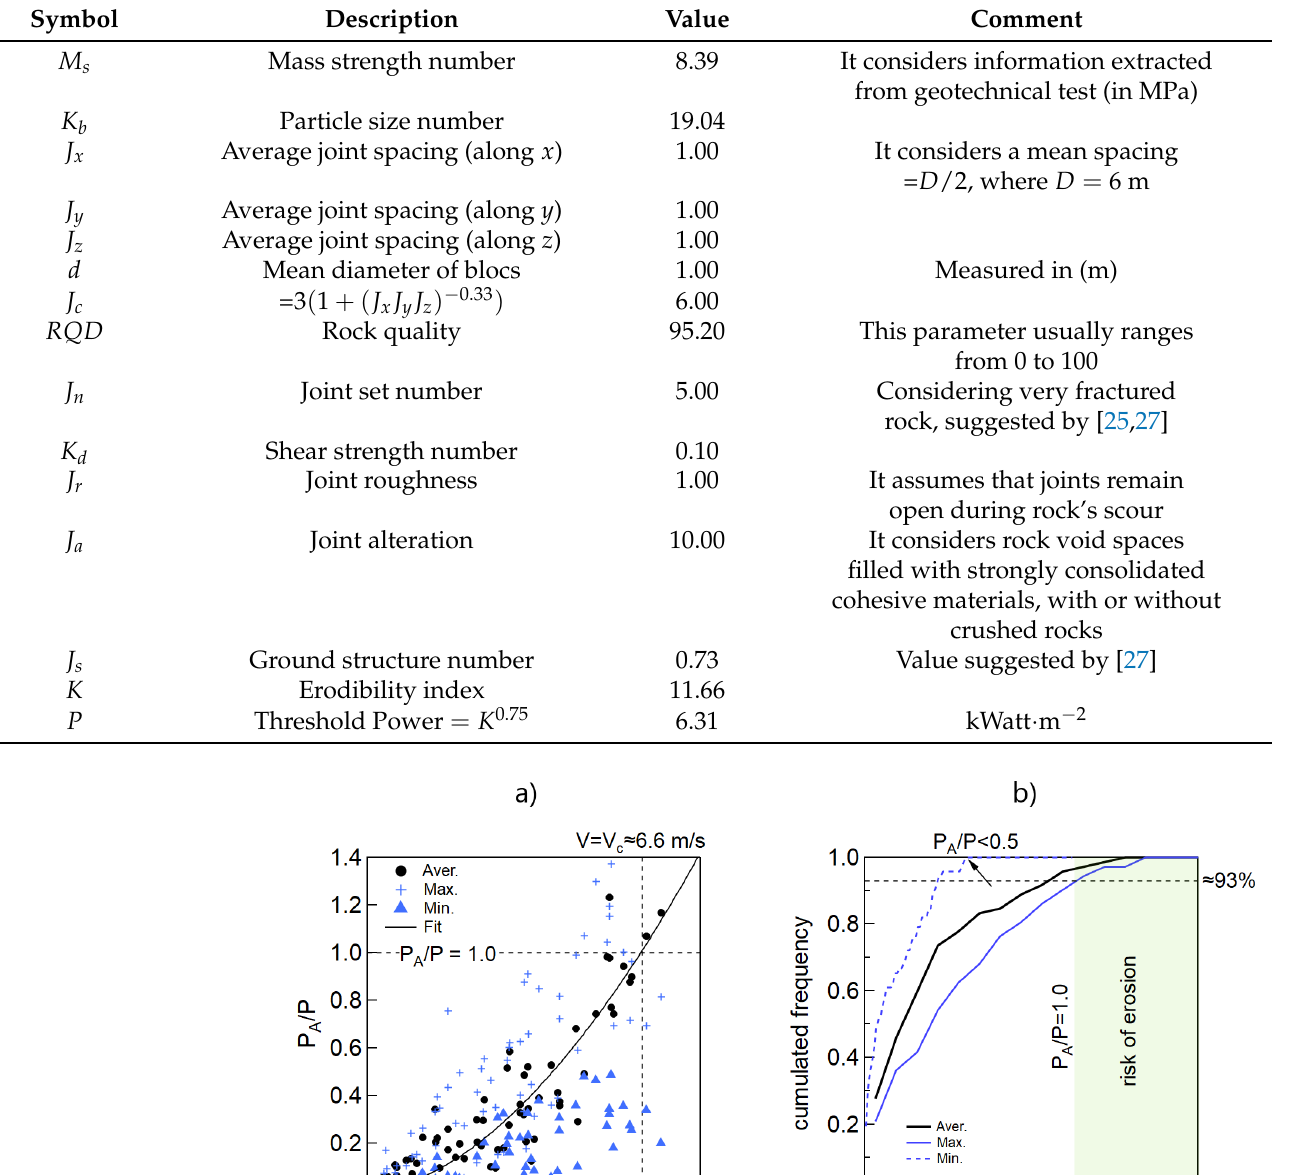
Table 5. Erodibility index K calculated for Remolinos rock. The parameters included in the table were already described in the text.